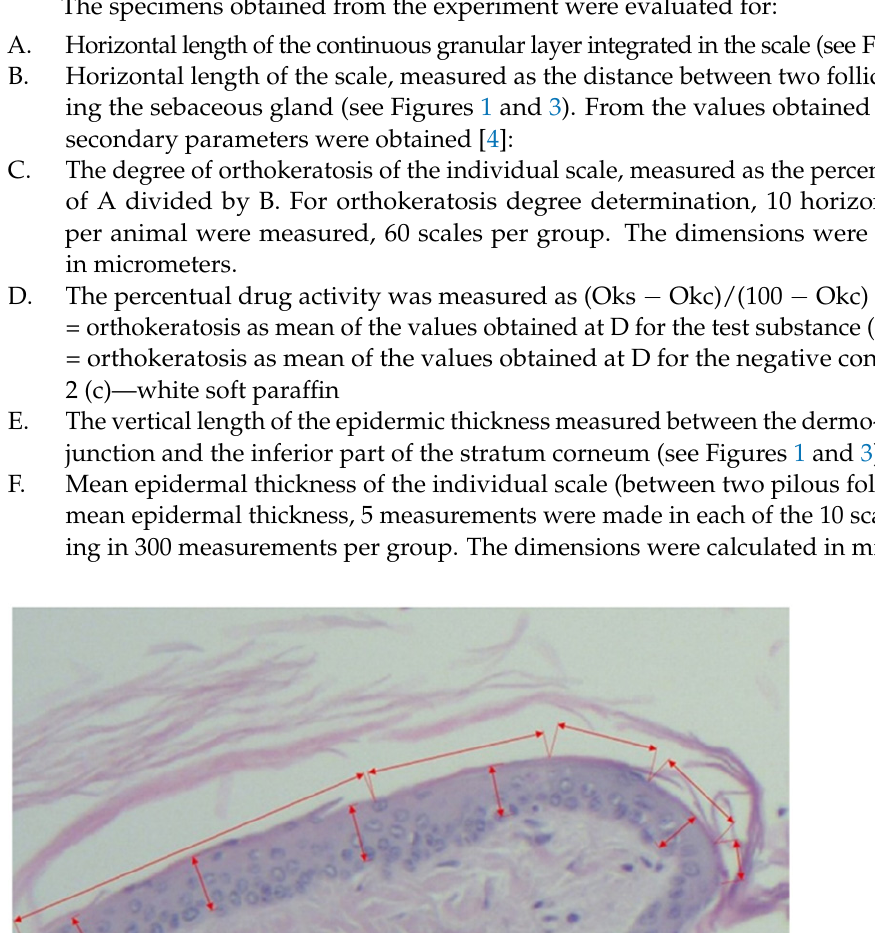
Figure 2. Section with granular layer, hematoxylin–eosin staining, 40× objective. Figure 3. Section group treated with 0.1 milliliter celecoxib 2% applied in the proximal part of the tail. The granular layer extends on the whole length scale, hematoxylin–eosin staining, 10× objective. 2.4. Statistical Analysis The statistical analysis was made with Microsoft Excel and SPSS version 25. For sta- tistical comparisons, the Kruskal–Wallis non-parametric test was used, with a level of sig- nificance set at p ≤ 0.05. 3. Results The values regarding the orthokeratosis degree, mean epidermic thickness and per- centual drug activity are presented in Table 1.